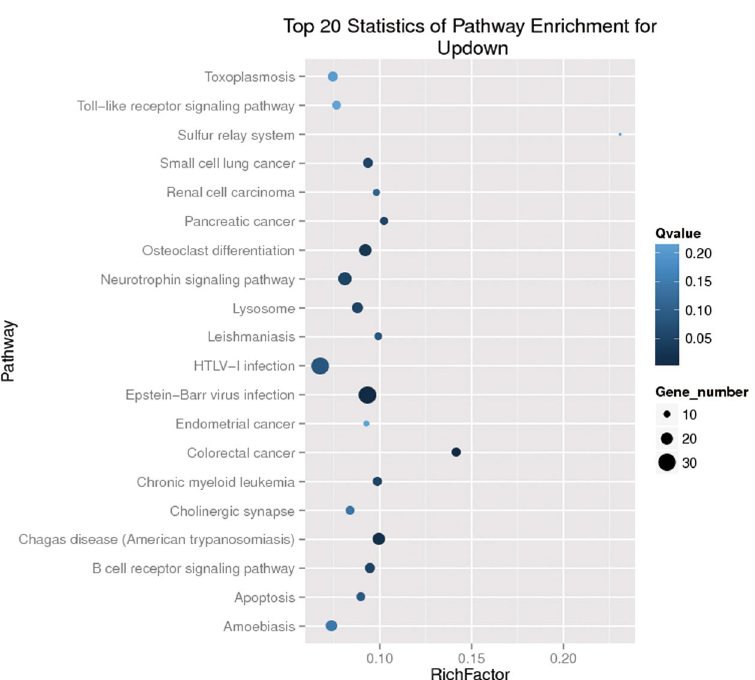
Figure 5. Scatter plot of KEGG pathway enrichment statistics. Top 20 statistics of pathways, enrichment in the KEGG database for neighbouring genes of predicted lncRNAs. Ten pathways had q values < 0.05 and were considered as significantly enriched